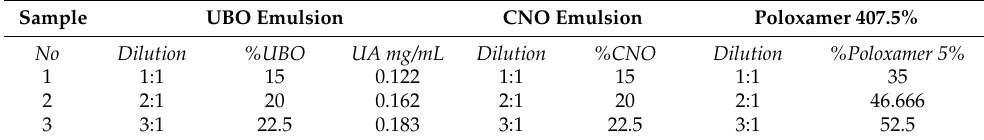
Table 11. The samples and control dilutions and/or concentrations used in BSL assay for 24 h. Sample UBO